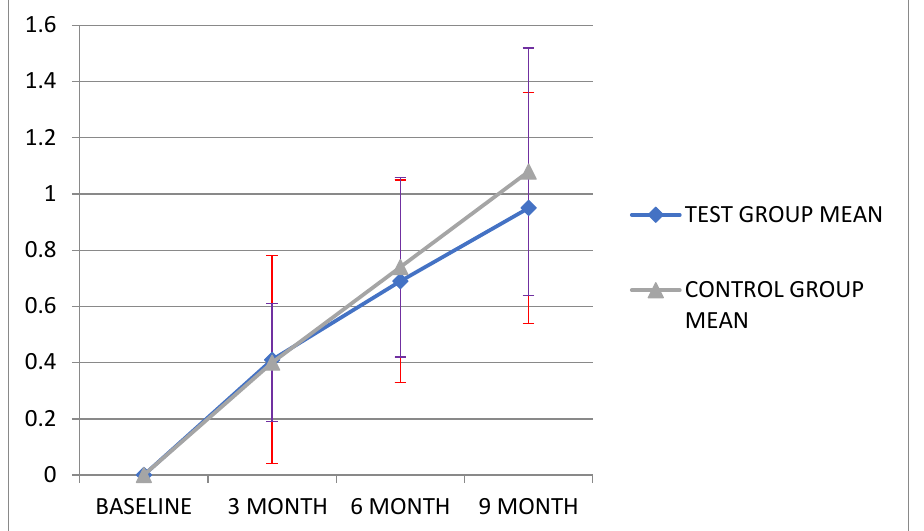
Scheme 2. Intergroup comparison of mean clinical attachment level.